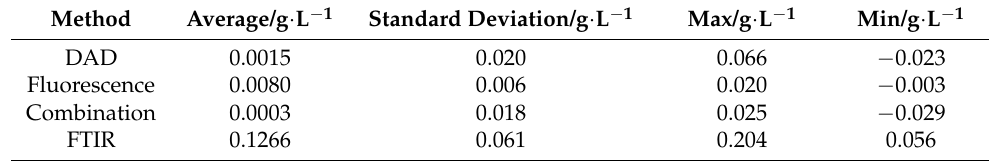
Table 3. Average, standard deviation, minimal and maximal measurement of zero-point